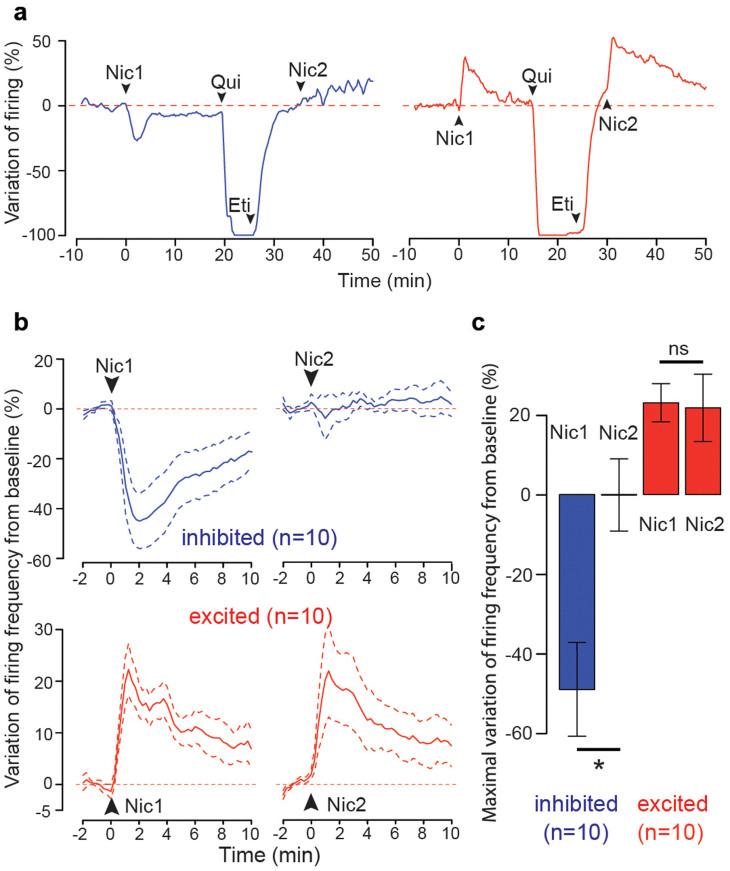
Abolition of nicotine inhibition but not excitation following D2-R blockade.(a) Example responses of an inhibited (left) and an excited (right) VTA DA neuron. Nic1, Nic2, Qui and Eti labelled arrowheads respectively represent the times of the first nicotine, second nicotine (both at 30 μg/kg), quinpirole (1 mg/kg), and eticlopride (1 mg/kg) intravenous injections. Red dotted lines represent baseline activity levels. (b) Mean responses to nicotine injection before (Nic1, left) and after (Nic2, right) D2 receptor (D2-R) blockade, in inhibited (top, n = 10) and excited (bottom, n = 10) DA neurons. Data are presented as mean (thick curves) ± SEM (dotted curves). Red dotted lines represent baseline activity levels. (c) Comparison of the maximal variation of firing frequency after nicotine injection before (Nic1) and after (Nic2) D2-R blockade, in inhibited (left, blue, n = 10) and excited (right, red, n = 10) DA neurons. For inhibited neurons, mean response before blockade: −44.8 ± 11.1 %, p < 0.01, exact Wilcoxon signed rank test; and after blockade: −2.4 ± 7.2 %, p > 0.05, exact Wilcoxon signed rank test; difference between the maximal amplitude of the two responses: 49.25 ± 16.5 %, p < 0.01, exact Wilcoxon rank sum test. For activated neurons, mean response before blockade: 20.5 ± 4.9%, p < 0.01, exact Wilcoxon signed rank test; and after: 20.2 ± 6.4 %, p > 0.05, exact Wilcoxon signed rank test; difference between the maximal amplitude of the two responses: −1.3 ± 8.6 %, p > 0.05, exact Wilcoxon rank sum test. Bars represent mean ± SEM; *: p < 0.01; ns: p > 0.05.